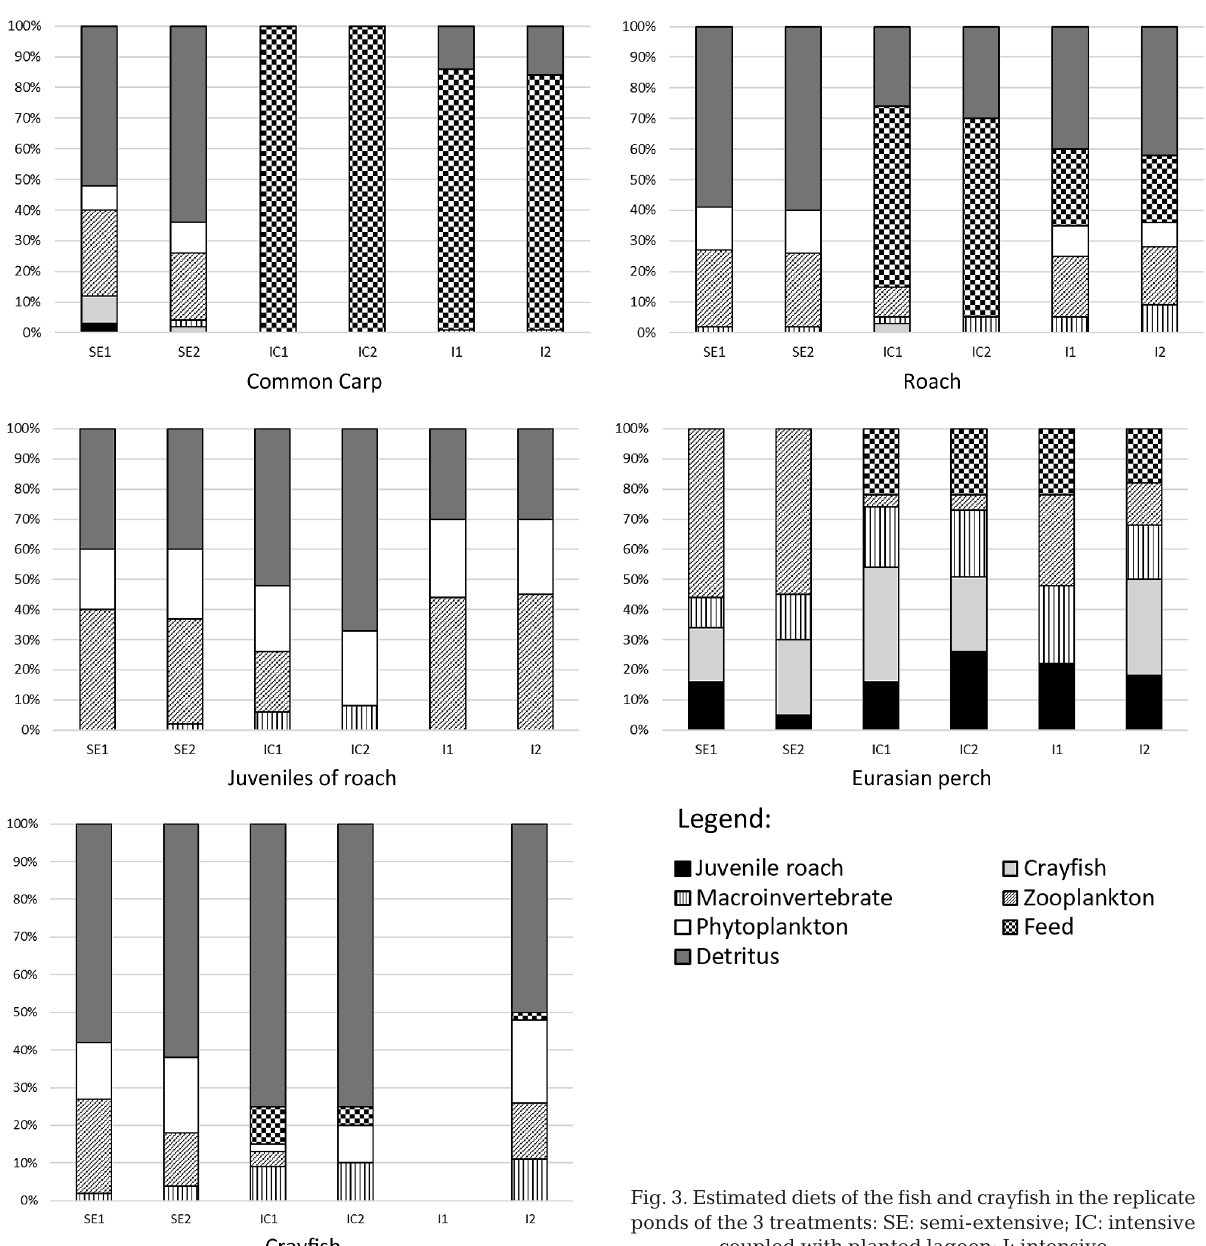
Fig. 3. Estimated diets of the fish and crayfish in the replicate ponds of the 3 treatments: SE: semi-extensive; IC: intensive coupled with planted lagoon; I: